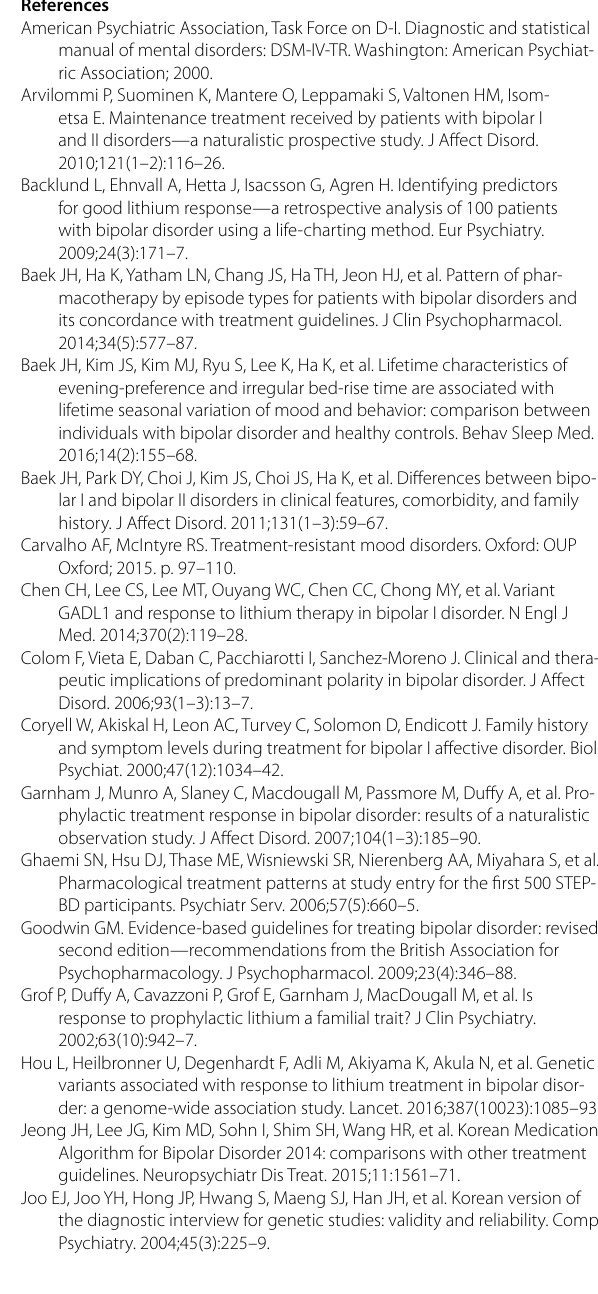
Additional file 1: Table S1. Model fitting evaluation of the total Alda scale score. Table S2. Comparison of lifetime symptom profiles of mood episodes between good responders and moderate/poor responders (N 60). Table S3. Comparison of the lifetime prevalence of co‑morbid = psychiatric illnesses between good responders and moderate/poor responders (N 60). Table S4. Comparison of baseline characteristics = by medication (N 80). Table S5. Comparison of symptom profiles by = medication (N 60). Table S6. Comparison of demographic data and = clinical course between good responders and moderate/poor respond‑ ers in patients with bipolar I disorder (N 65). Table S7. Comparison = of symptom profiles between good responders and